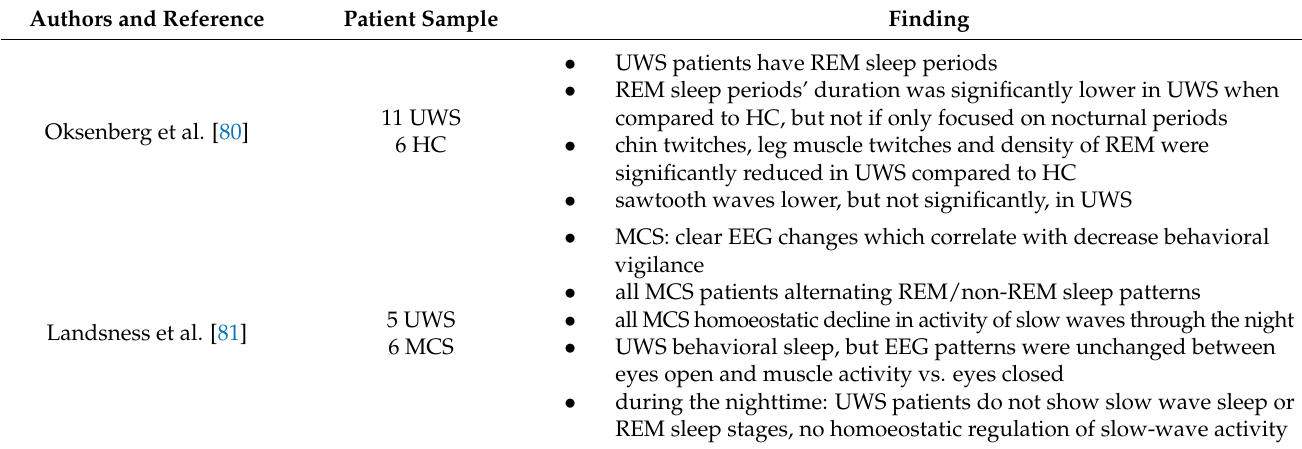
Table 2. Overview of findings for diagnosis and sleep patterns; abbreviations can be found in Abbreviation. Authors and